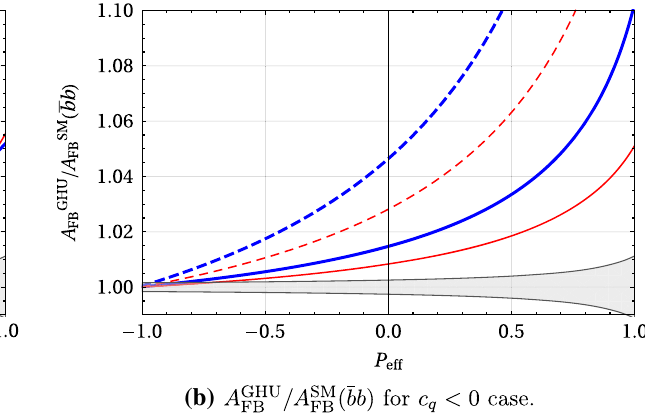
Fig. 4 Ratio of the forward–backward asymmetry in the GHU model to that in the SM with polarisation beams for the e + e − → ¯ bb process. The left figure shows the c q > 0 case and the right figure shows the √ c q < 0case.Solidanddottedlinesarefor s = 250 GeVand500 GeV, c q > 0 ( ¯ tt )/ A SM ( ¯ tt ) − 1 = 5 . 36%, 5 . 03%, 5 . the SM. A FB FB